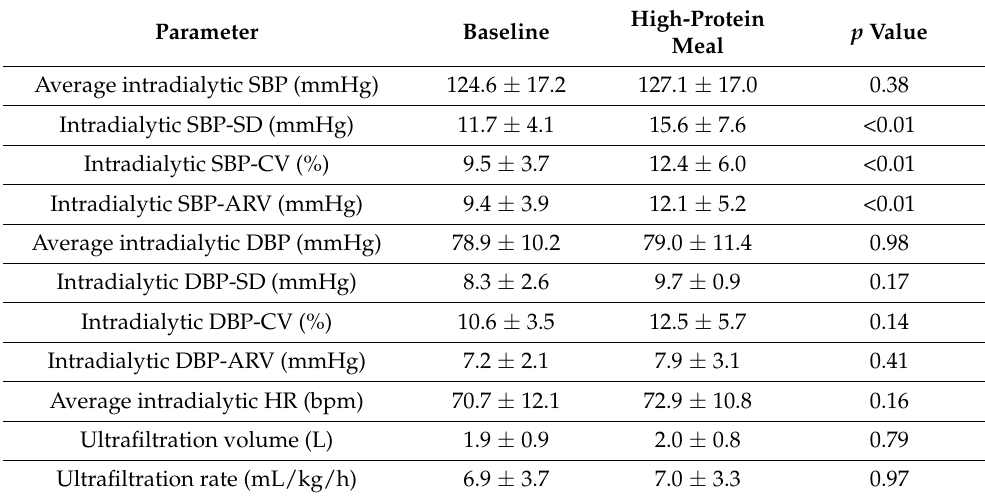
Table 2. Intradialytic BP variability parameters at baseline and in phase A of the study. Parameter